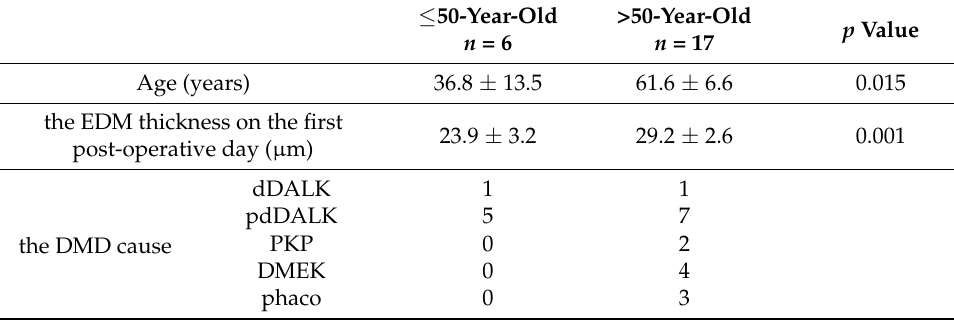
Table 1. Demographic data in the ≤ 50-year-old and >50-year-old